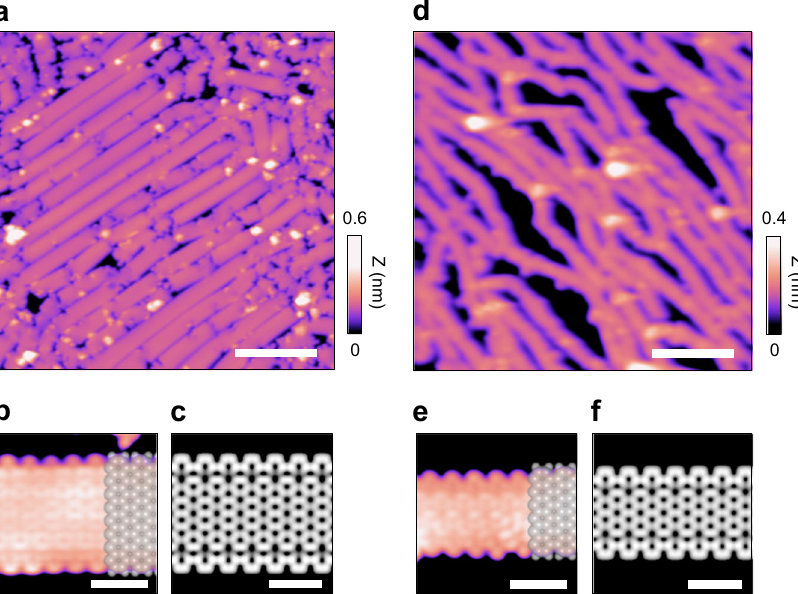
Fig. 3 STM and DFT simulated images of 17- and 13-AGNRs. a Overview STM image ( V s = − 1.2 V, I t = 10 pA) of 17-AGNRs on Au(111). b High-resolution STM image ( V s = − 1.4 V, I t = 1.0 nA) of single 17-AGNR together with structural model. c DFT-simulated image ( U = − 1.4 eV) of the 17-AGNR. d Overview STM image ( V s = − 1.5 V, I t = 20 pA) of 13-AGNRs on Au(111). e High-resolution STM image ( V s = − 1.6 V, I t = 1.2 nA) of single 13-AGNR together with structural model and f corresponding DFT-simulated image ( U = − 1.6 eV). Overview and high-resolution images were taken at 77 and 5 K, respectively. Scale bar, 10 nm in a , d , 1 nm in b , c , e , f